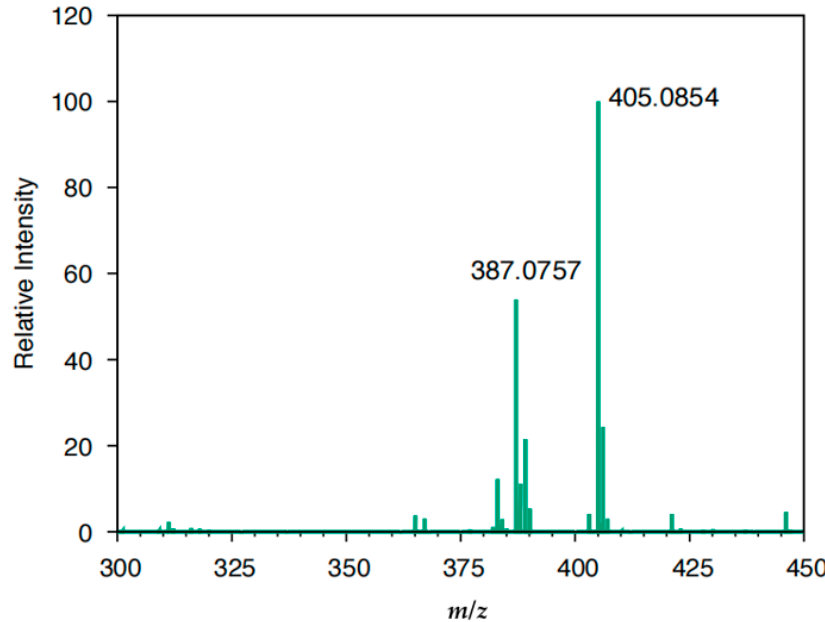
Figure 2. MS of PFA.